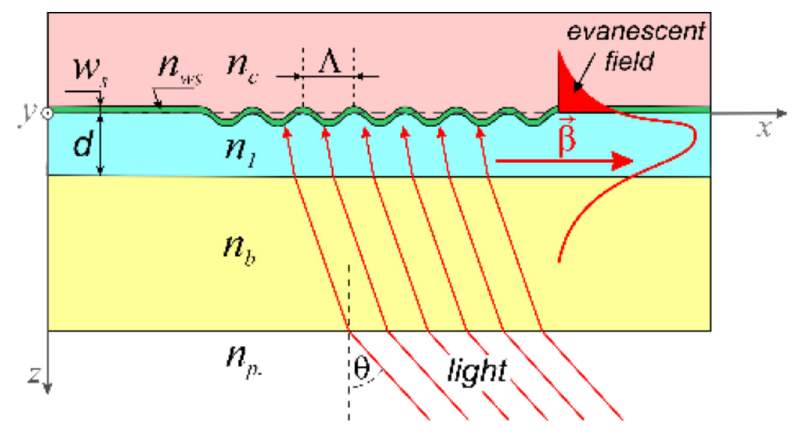
Figure 1. Planar sensor structure with a grating